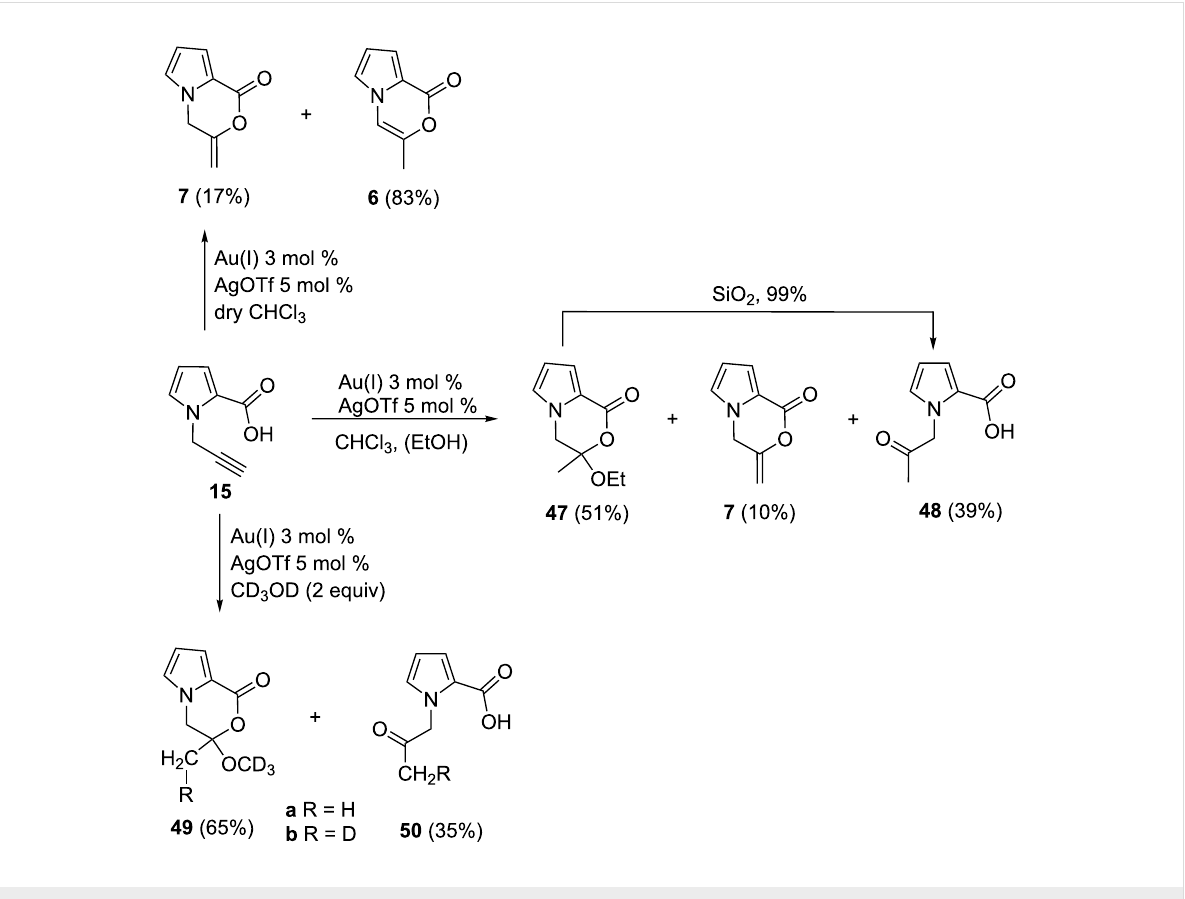
Scheme 4: Reaction of 15 with Au(I)/AgOTf in the presence of EtOH and CD 3